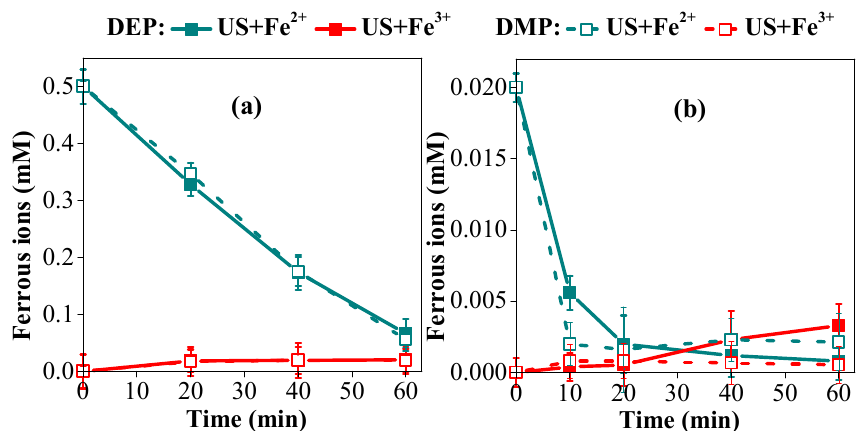
Figure 3. Variation of ferrous ion concentrations during the degradation of DMP or DEP in sono-Fenton and sono-Fenton-like processes at two different levels of iron species: ( a ) 0.5 mM, ( b ) 0.02 mM ([DMP] 0 = 0.01 mM, [DEP] 0 = 0.01 mM).